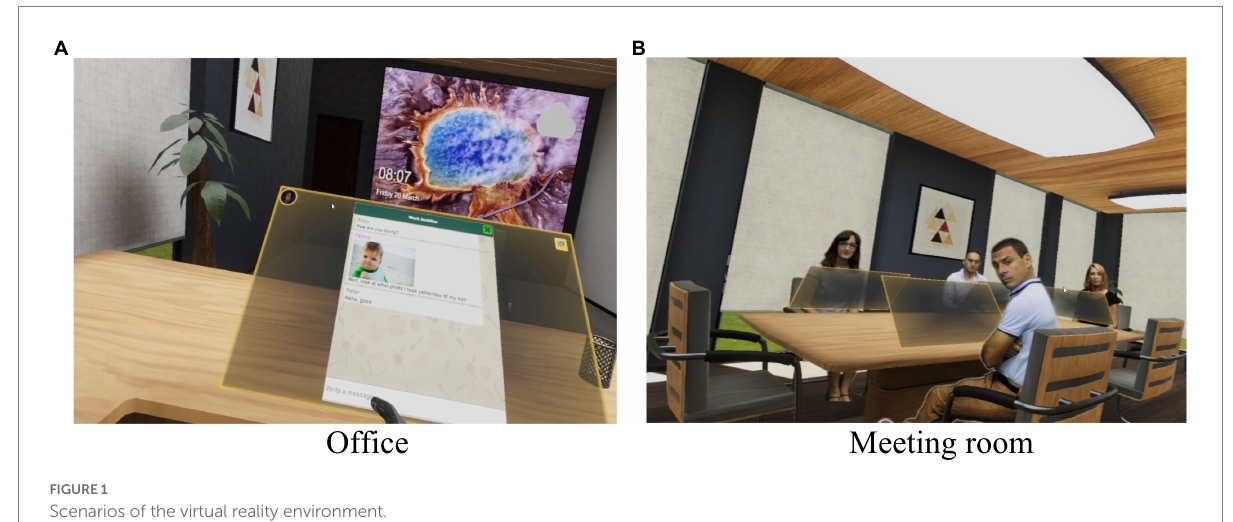
FIGURE 1 Scenarios of the virtual reality